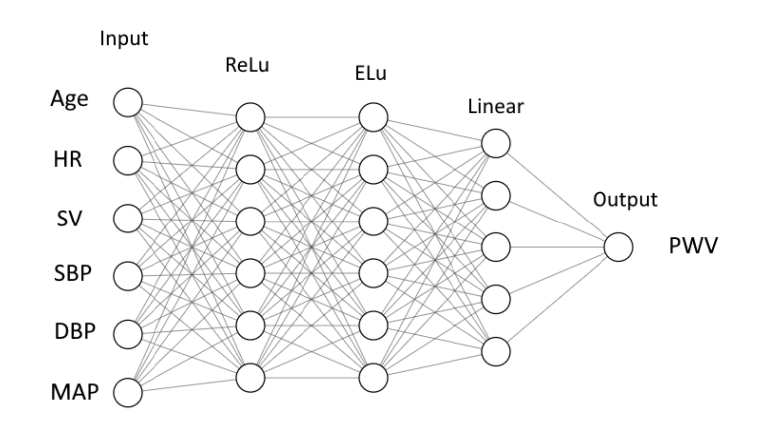
Figure 2. Structure of neural network: inputs, output, layers, number of neurons in each layer and activation functions (ReLu, ELu and Linear—Figure